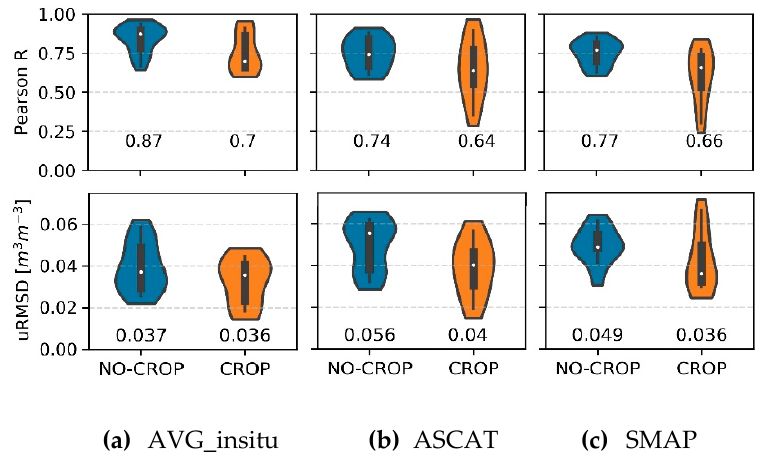
Figure 5. Violin plots of Pearson R (top) and uRMSD (bottom) between measured and predicted soil moisture (model combination SSM + S + T + V) depending on the vegetation type. CROP indicates agricultural fields, while NO-CROP includes grassland, forest, and field edges. The SSM source used as model predictor is displayed above each graph. The boxplots within the violins indicate quartiles and the white dots depict the median values (also reported below the violins). ( a ) AVG_insitu, ( b ) ASCAT, ( c )